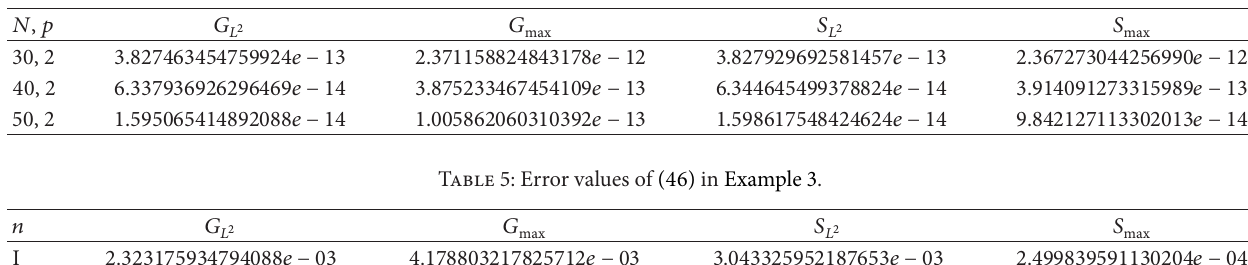
Figure 4: Convergence graphs of relative error in 𝐿 2 -norm and maximum norm via Sloan iteration for (45) in Example 2. Table 4: Error values of (45) in Example 2.